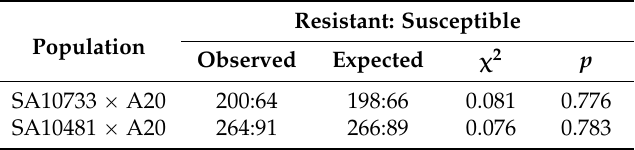
Table 2. Segregation of resistance to pea aphid in resistant M. truncatula accession crossed with accession A20. Chi-square analysis for a single dominant Mendelian inheritance of resistance of the two F 2 populations indicates single dominant, Mendelian inheritance of resistance to PA in both populations.